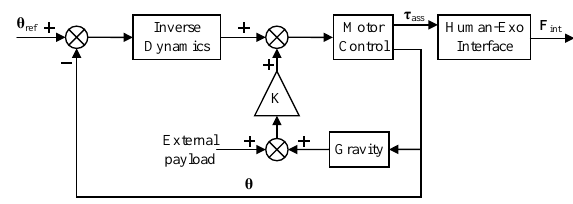
Figure 4: Implementation of the control strategy in the human-exoskeleton model, F int standing for assistive interaction force to human limb where K = diag( k 1 , k 2 , k 3 , k 4 ) is the assistance levels at all joints. It should be noted that k 2 and the sec- ond entry of τ exo are equal to zero, as joint 2 in our exoskeleton is a passive